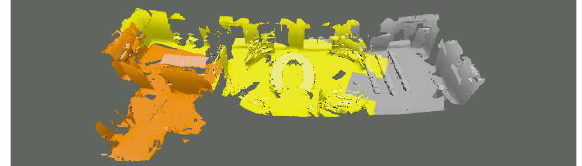
Figure 2. The colours and time thresholds are set dynamically by the coordinator, as different operators might prefer different settings for different operation environments.